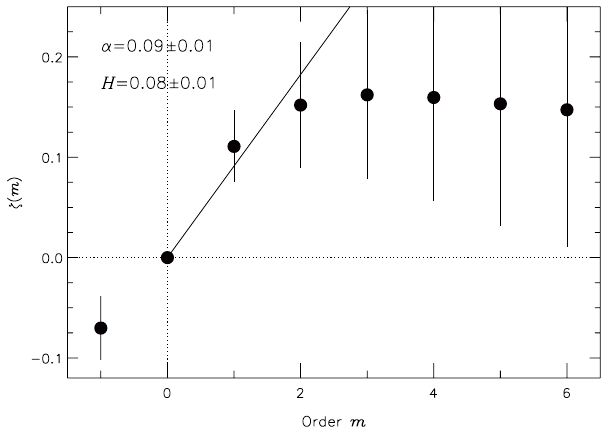
Fig. 10. The gradients of the weighted least squares curves ζ ( m) es- timated from Fig. 8, versus order m over the range m = − 1 to 6. The error bars are drawn at the 3 σ level. The gradient of the weighted least squares curve to the ζ ( m) points between m =0 and m =2 gives α GSF =0.09 ± 0.01 (1 σ